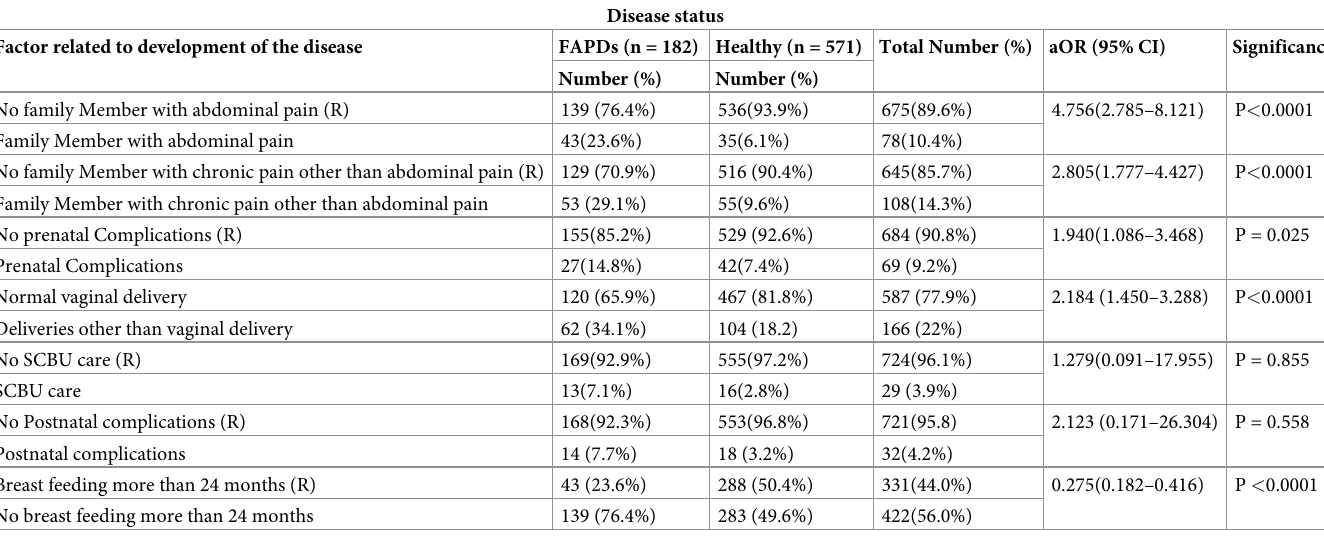
Table 2. Multivariate analysis to identify risk and protective factors for development of